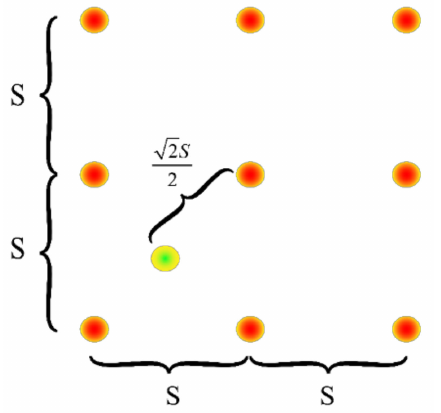
Figure 10. Set the distant threshold of positive and negative sample